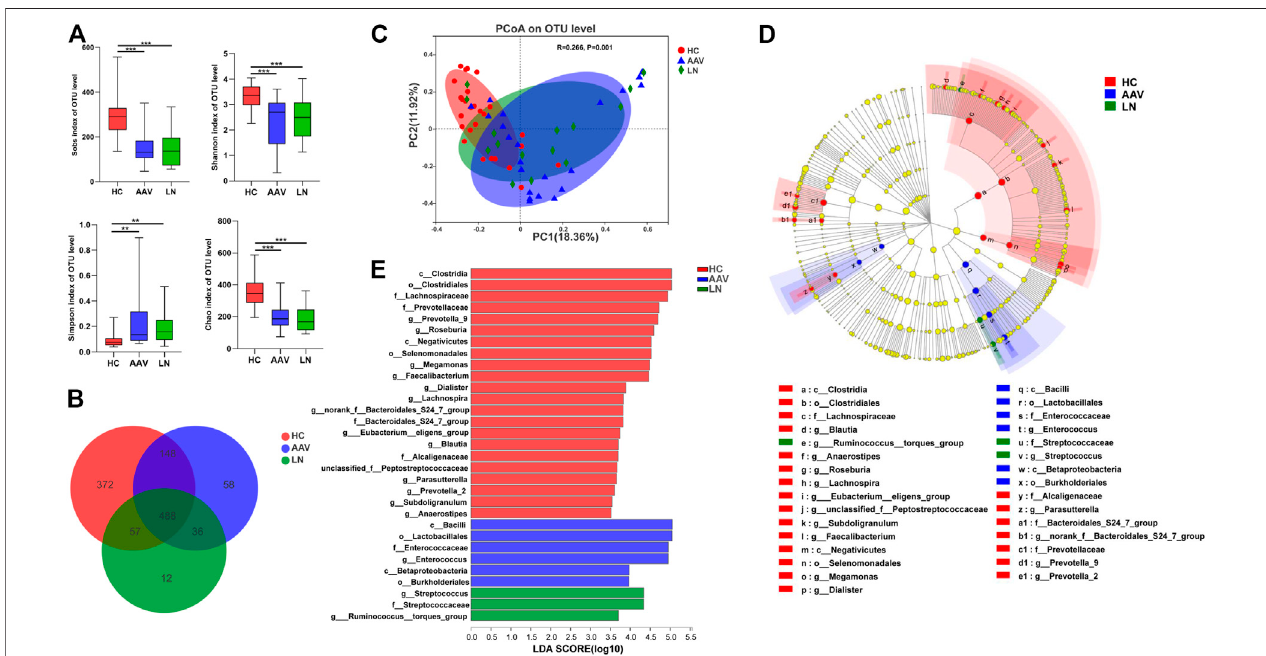
FIGURE1| Comparison ofgutmicrobiota ofAAV patients,LNpatients and healthycontrols. (A) Alphadiversity indices(Chao, Simpson, Sobsand Shannon) were signi fi cantly lower in AAV and LN than that of HC. (B) A Venn diagram displaying the overlaps among groups showed that 488 OTUs were shared in all groups, while 58 were unique for AAV. (C) The PCoA based on OTUs distribution showed that the gut taxonomic composition was signi fi cantly different between AAV and HC. (D) The enriched taxain theAAV,LNand HC gutmicrobiomes were represented inthecladogram. Thecentral point representstherootofthetree(bacteria) and each ring represents the next lower taxonomic level. (E) Crucial bacteria of gut microbiome related to AAV. Based on the LDA selection, 6 genera were signi fi cantly enriched comparedwithLNandHC.* p < 0.05;** p < 0.01;*** p < 0.001.AAV,ANCAassociatedvasculitis;LN,lupusnephritis;HC,healthycontrols;OTUs,operationaltaxonomic units; PCoA, principal coordinate